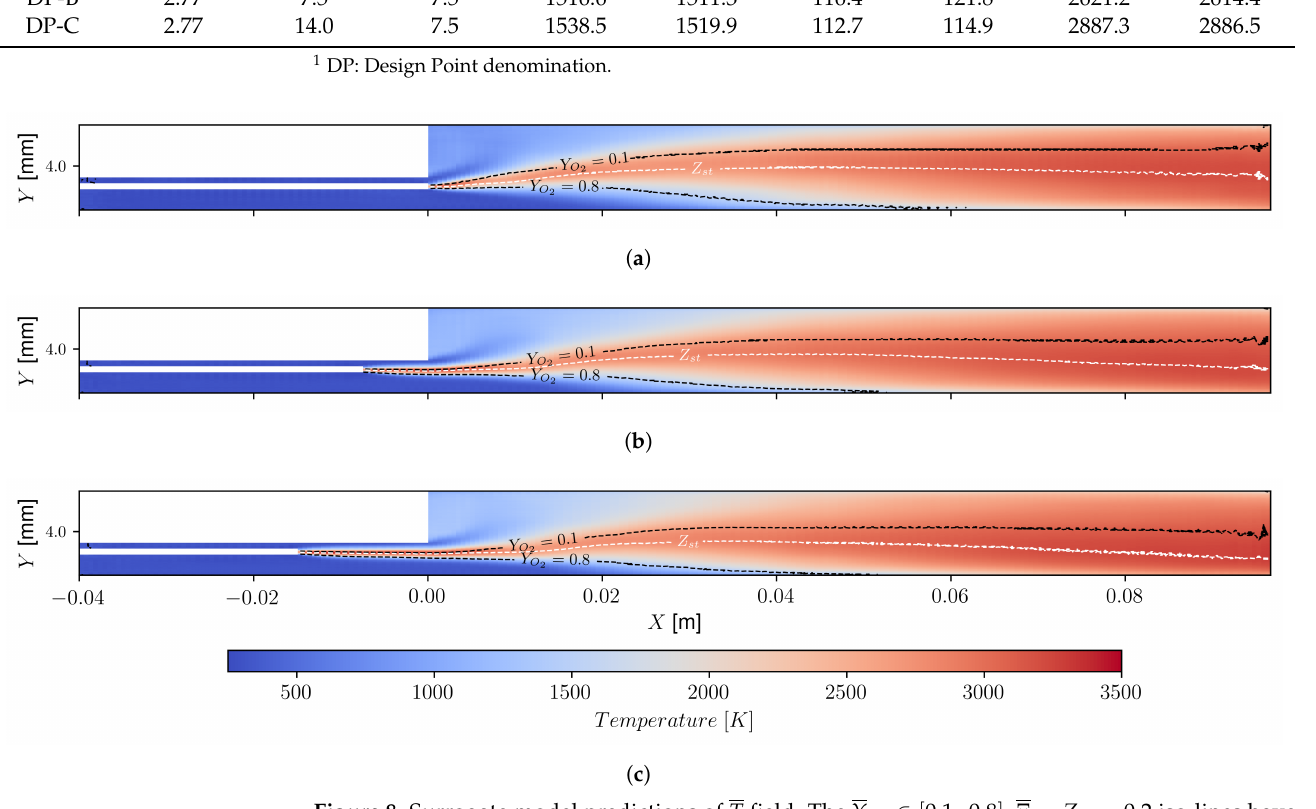
Figure 8. Surrogate model predictions of T field. The Y O been included, as given by their corresponding models. ( a ) DP-A, ( b ) DP-B, and ( c ) DP-C evaluations. The aspect ratio of the figures was modified purposely to facilitate their